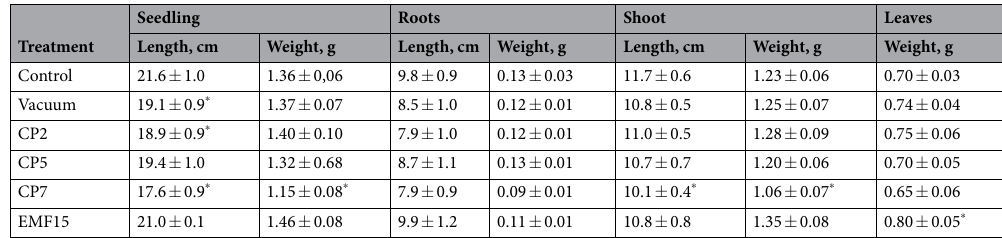
Table 2. Morphometric parameters of sunflower seedlings 2 weeks after sowing. Mean values ± standard error are presented (n = 17–24 seedlings), * significantly different from the control group (p ≤